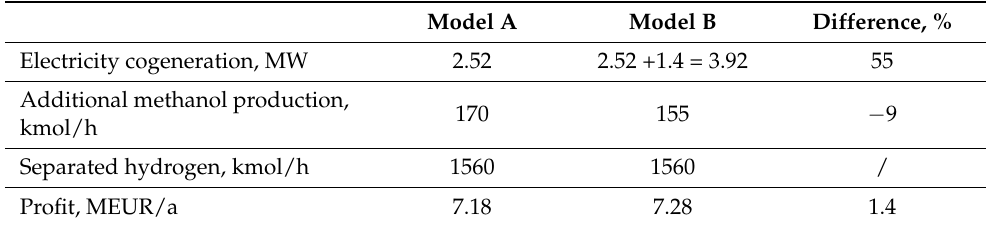
Table 1. The comparison between Models A and B for the crude methanol production from polyethy- lene waste and flue gas. Model A Model B Difference,